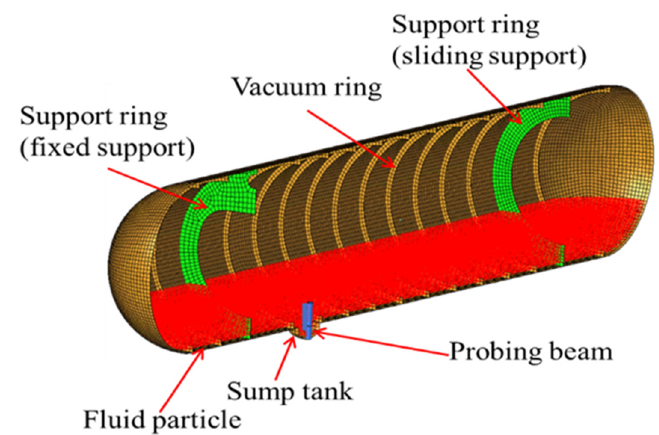
Figure 5. A typical example for the tank heel analysis model.